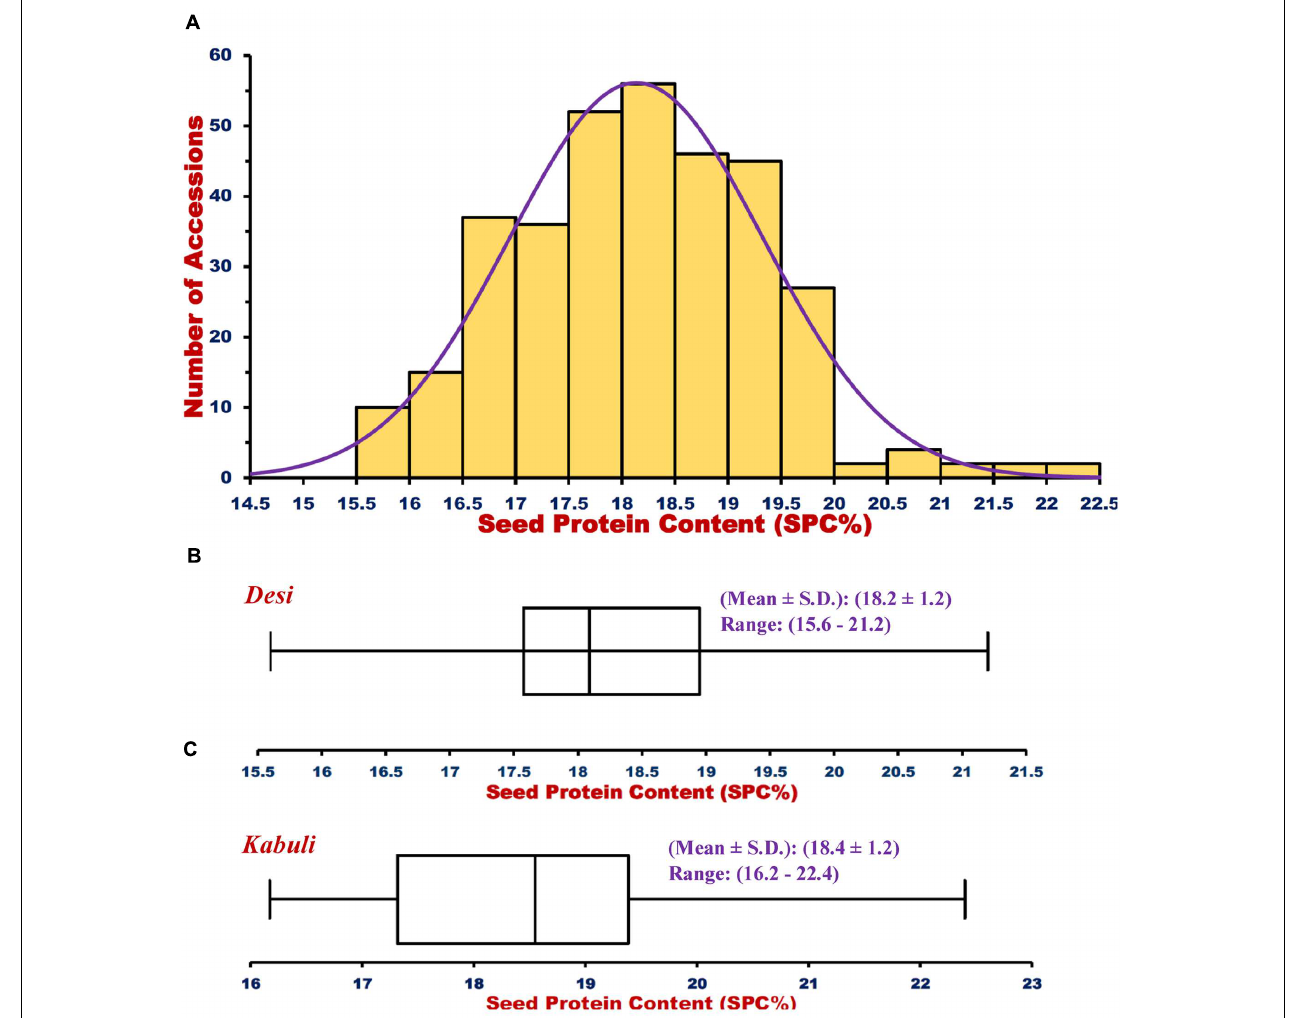
FIGURE 1 | (A) Frequency distribution of seed-protein content (SPC %) trait variation measured in a structured population of 336 desi and kabuli chickpea accessions illustrated a goodness of fit to the normal distribution. Boxplots depicting the variation of SPC trait across 206 desi (B) and 120 kabuli (C) chickpea accessions. Box edges signify the lower and upper quantiles with median values in the middle of the